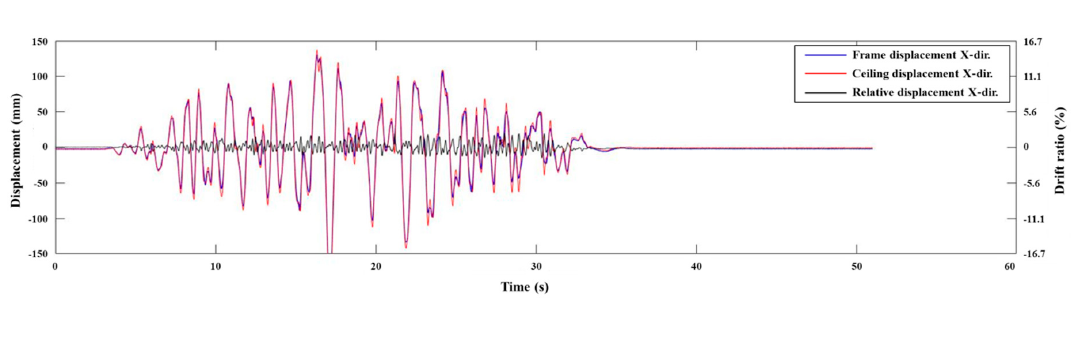
Commented [M4]: Please check the figure and consider change the hyphen into minus sign on axis. Author: Corrected the figure.